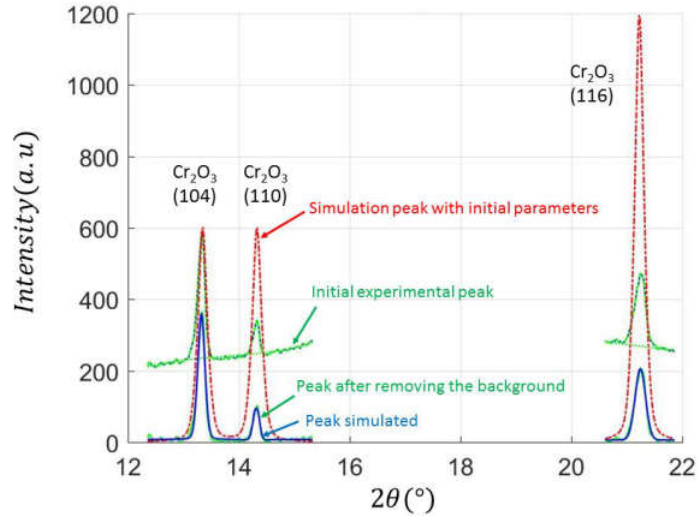
Figure 7. Fitting of the peak profiles with or without background, as performed in [16].